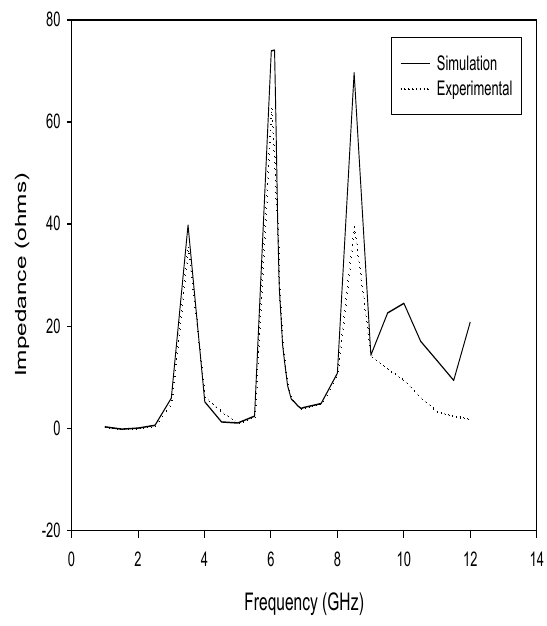
Figure 4. Simulation and Experimental variation of Impedance with frequency (without defect).